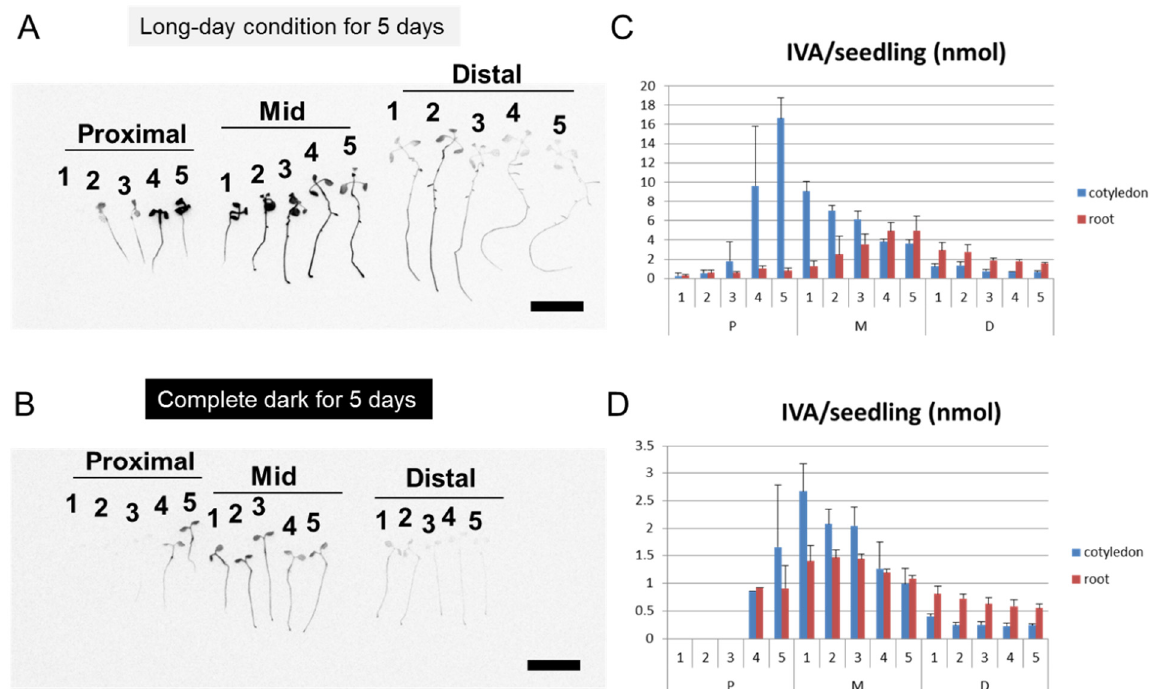
Figure A6. Light condition affects the incorporation rates of 14 C-labeled IVA into the Arabidopsis seedlings. Bars: 1 cm. Numbers represent individual seedlings. ( A ) Autoradiogram of the Arabidopsis seedlings that were subjected to the bioassay 14 C-labeled IVA under the long-day photoperiod for 5 days. ( B ) Autoradiogram of the Arabidopsis seedlings that were subjected to the bioassay 14 C- labeled IVA under the complete dark condition for 5 days. ( C ) Radioactivity detected either from the cotyledons or the roots of the Arabidopsis seedlings from the bioassay in ( A ). ( D ) Radioactivity detected either from the cotyledons or the roots of the Arabidopsis seedlings from the bioassay in ( B ).